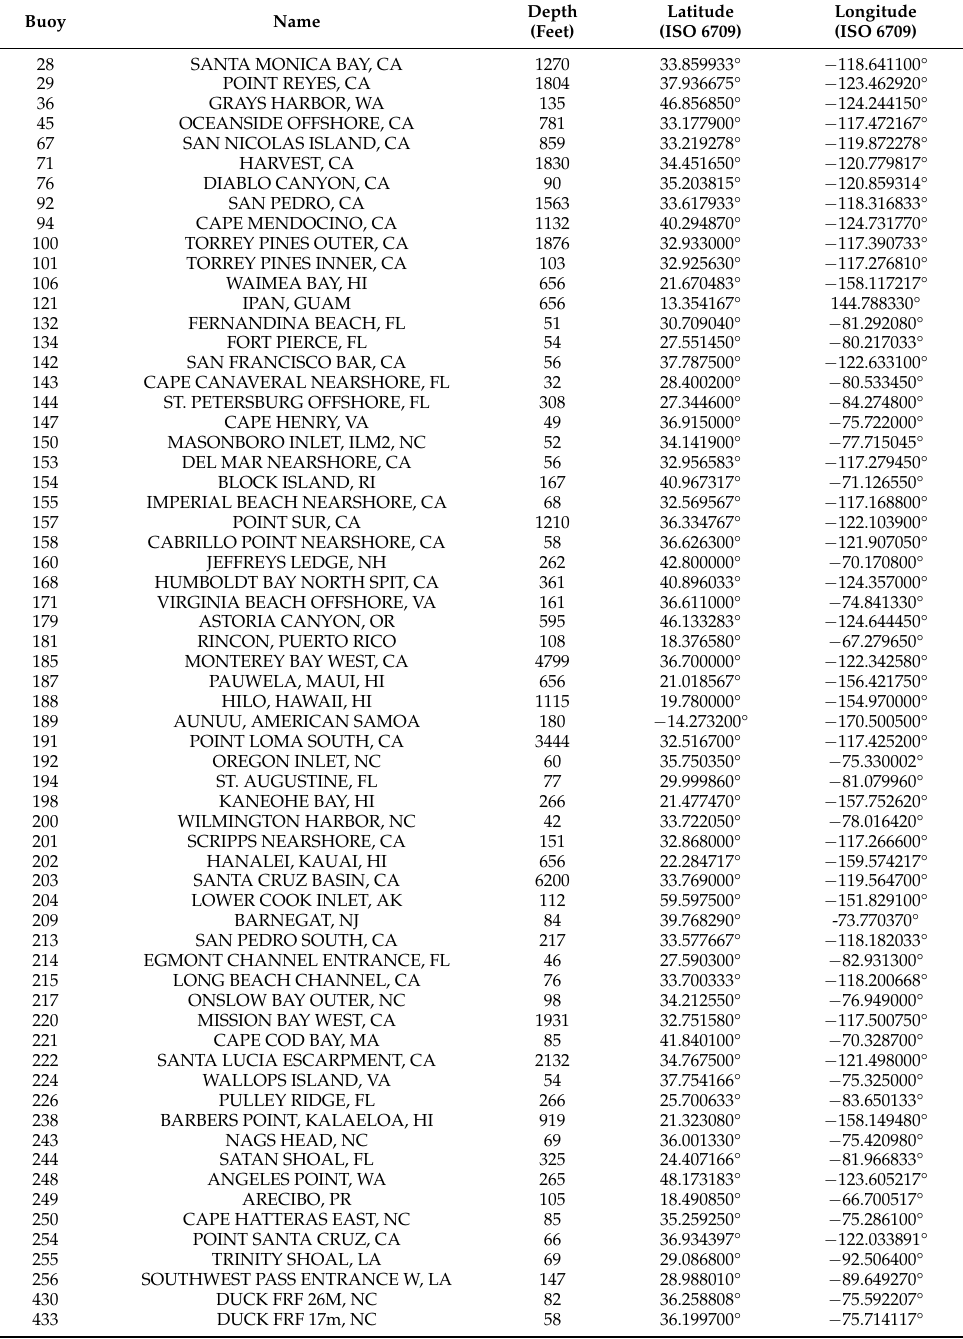
Table 1. Identification number (first column), name (second column), depth (third column), latitude (fourth column), and longitude (fifth column) of the 64 buoys included in this